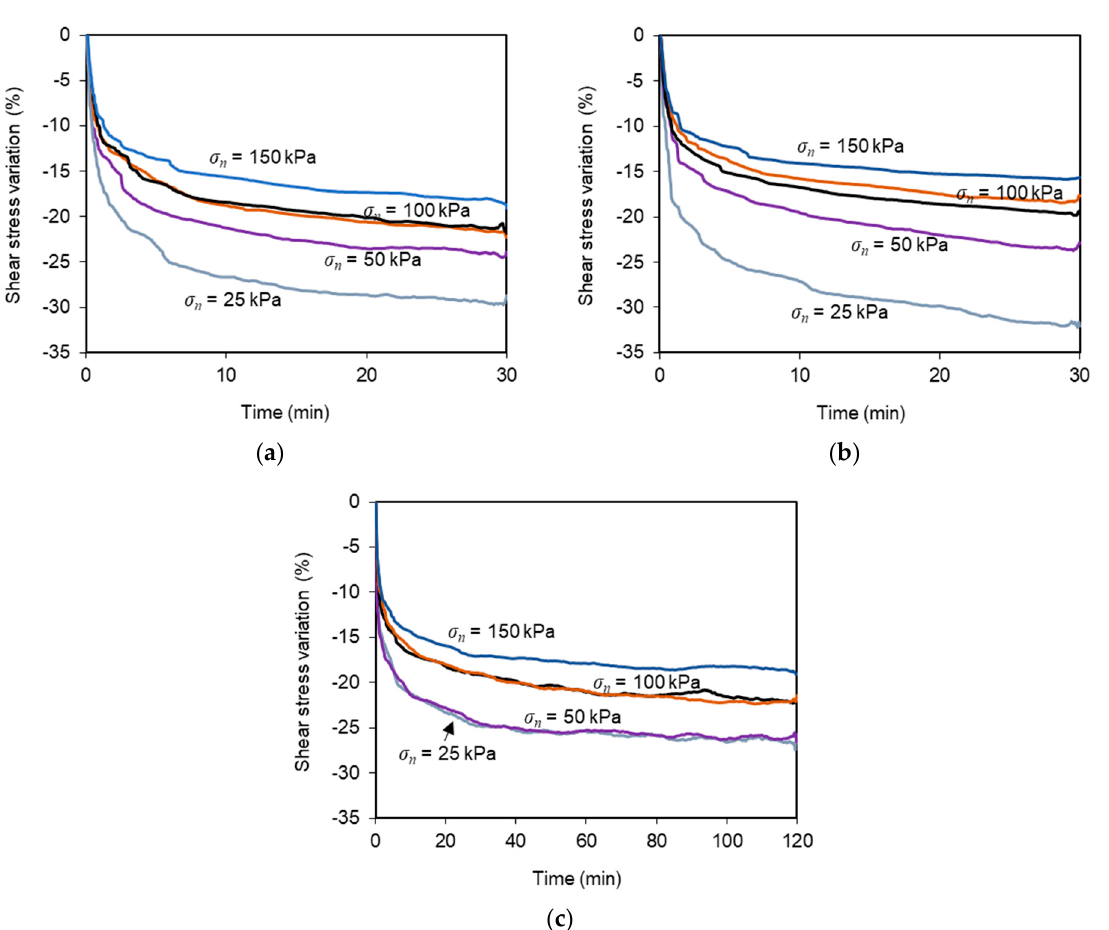
Figure 6. Percent variation of shear stresses over time during the stress relaxation stage: ( a ) d r /d max = 1/3 and t r = 30 min (tests T-6 to T-10); ( b ) d r /d max = 2/3 and t r = 30 min (tests T-11 to T-15); ( c ) d r /d max = 2/3 and t r = 120 min (tests T-16 to T-20).